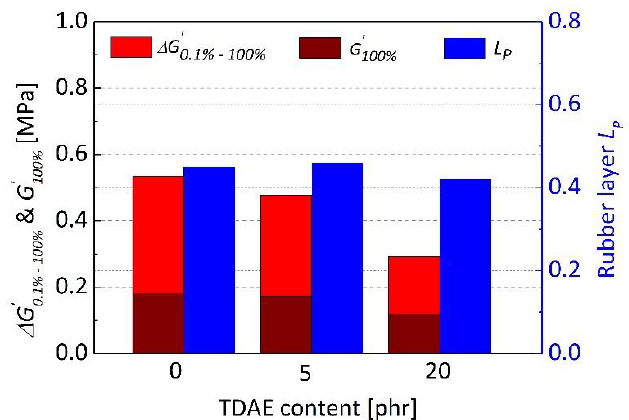
Figure 6. Difference between storage shear modulus at 0.1% and 100% strain amplitudes (Δ G ′ 0.1%– 100% ), the storage shear modulus at 100% strain amplitude ( G ′ 100% ) and the plateau value of rubber layer (𝐿 𝑃 ) relation of uncured silica-filled SBR/BR blends depending on TDAE